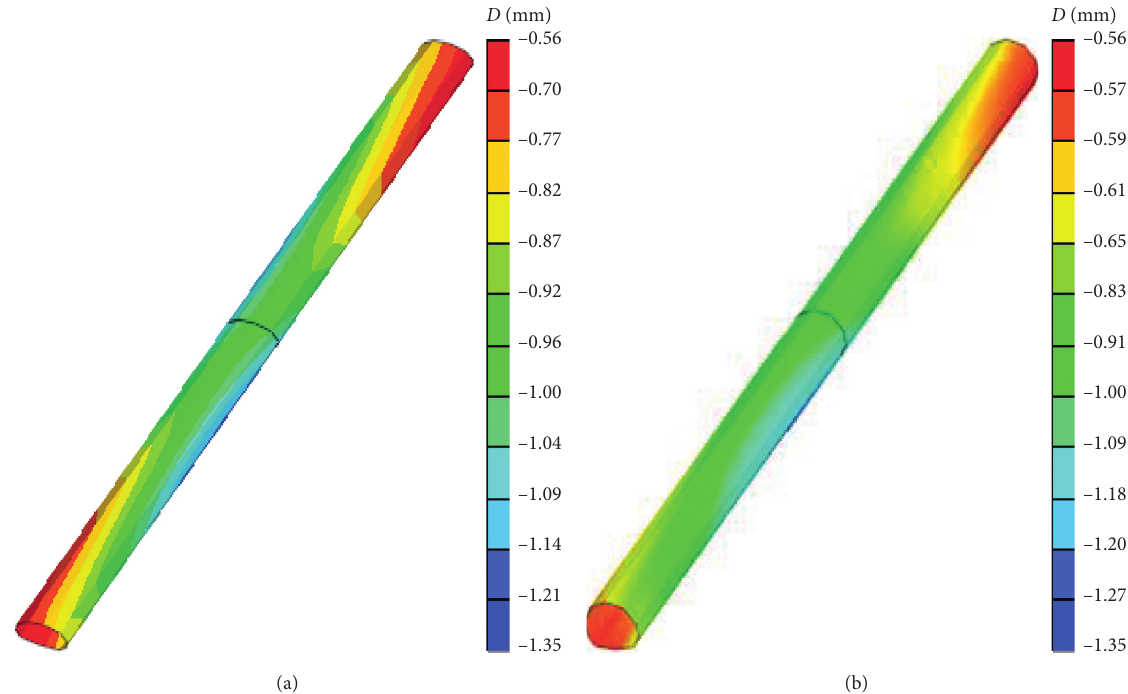
Figure 5: Cloud diagram of vertical settlement of the existing tunnel lining. (a) Excavation program I. (b) Excavation program